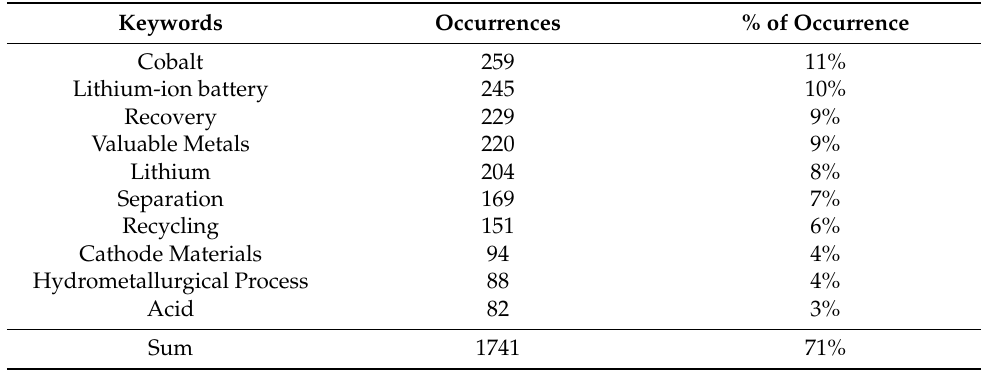
Table 2. Most used keywords in LIB recycling published